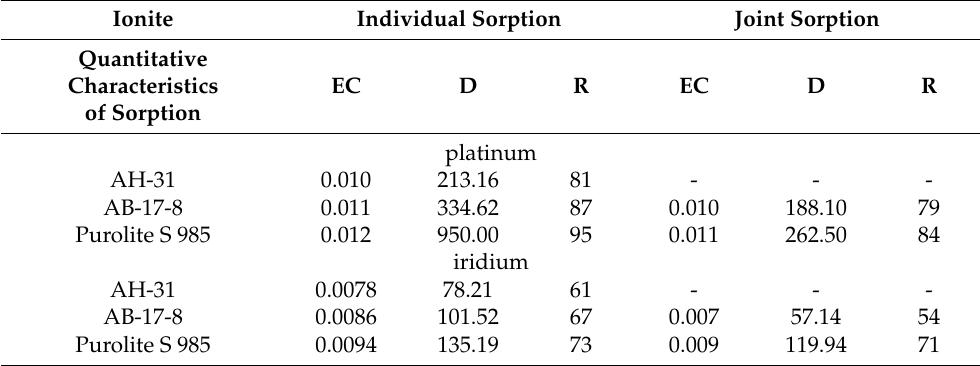
Table 2. Sorption recovery of platinum and iridium from individual and combined